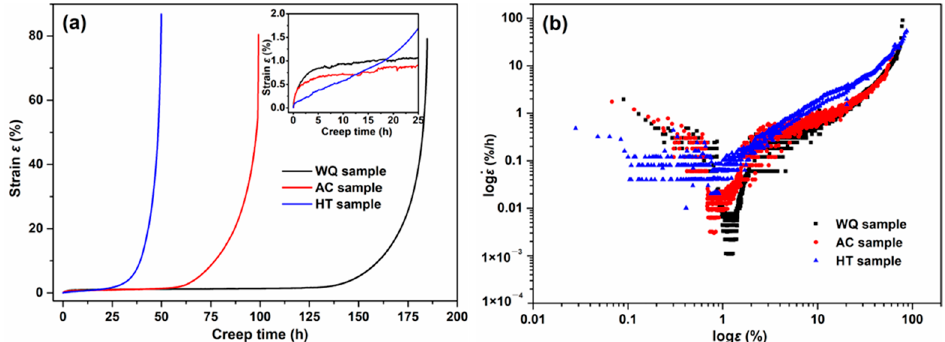
Figure 11. ( a ) Creep strain–time curves (The inset shows the primary stage of creep); ( b ) strain rate with respect to strain of the different heat treatment sample at 1100 °C/137 MPa.